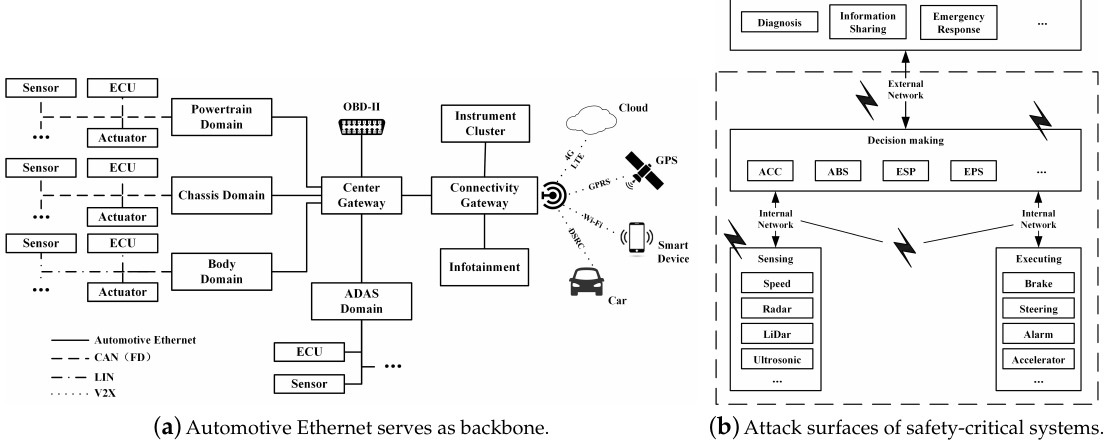
Figure 1. Automotive electrical and electronic architecture (EEA) and attack